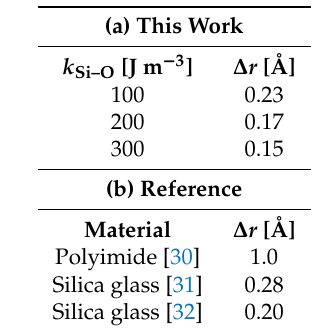
Figure 2. Temperature dependency of the mean displacement of oxygen atoms at different values of k parameter. Table 2. Oscillative mean displacement of the atoms of several materials at 300 K.